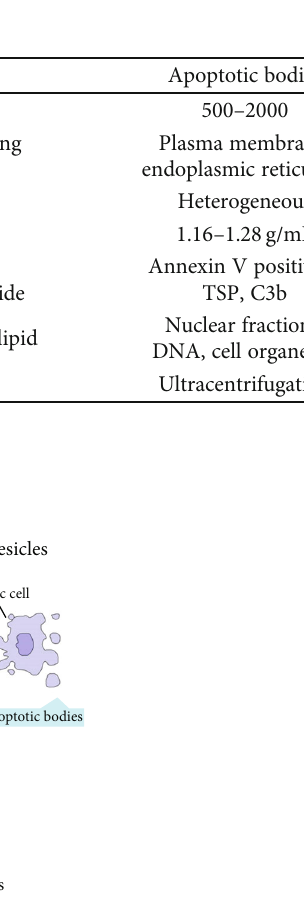
Figure 2: SARS-CoV-2 enters into the human lung and the MSCs-EVs are considered a promising treatment due to their e ff